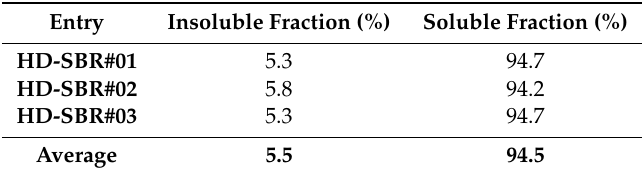
Table 5. Insoluble (gel) and soluble fractions of the SBR latex synthesized through seeded miniemulsion polymerization using in-situ generated surfactant and HD as the hydrophobe. Entry